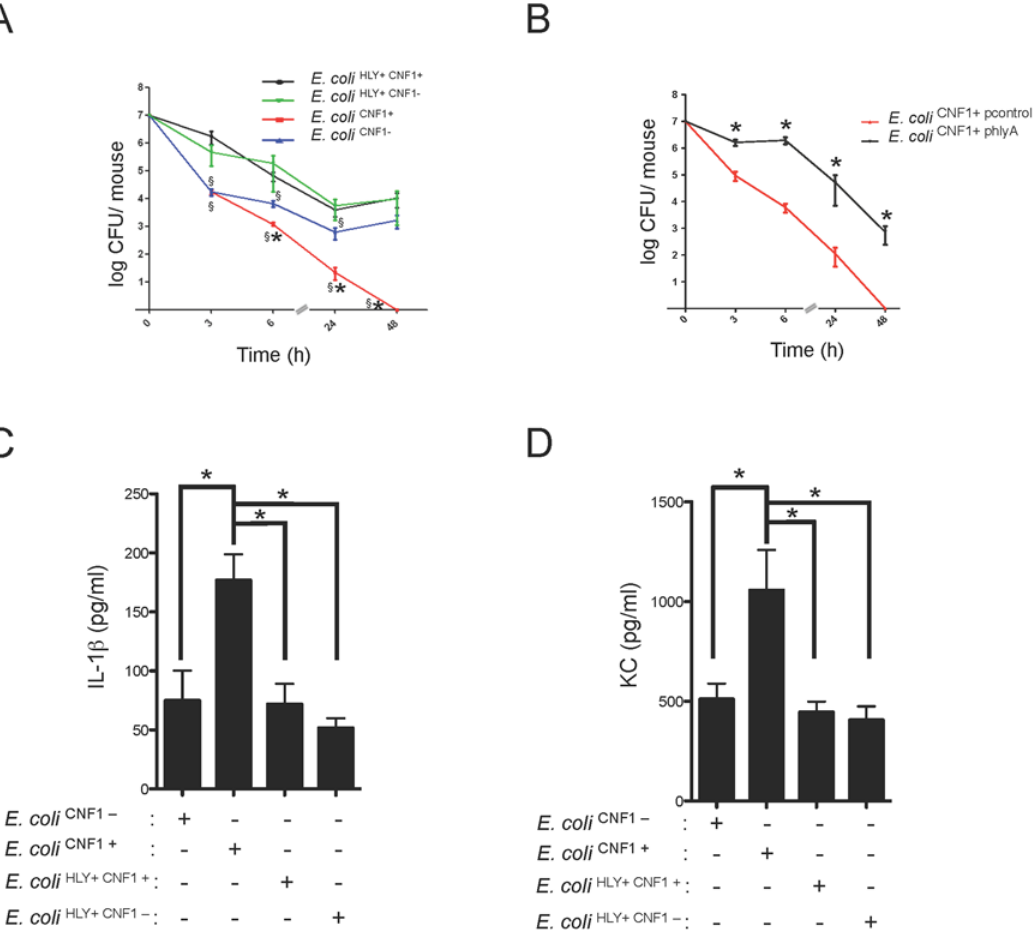
Fig 5. HlyA counteracts the CNF1-induced host response. (A) Female BALB/c mice were intravenously infected with 10 7 CFUs of E . coli expressing CNF1 ( E . coli CNF1+ ) or with 10 7 CFUs of one of the isogenic mutants, E . coli CNF1- , E . coli HLY+ CNF1+ or E . coli HLY+CNF1- , prior to the collection of peripheral blood at 3, 6, 24 and 48 h for bacteremia measurements. The data are presented as a line graph (n = 20 – 30; mean ± SEM). P-values < 0.05 compared to E . coli CNF1- are indicated by ( * ); and P-values < 0.05 compared to E . coli HLY+ CNF1+ are indicated by (§). (B) Female BALB/c mice were intravenously infected with 10 7 CFUs of the UTI89 Δ hlyA strain transformed with a control empty plasmid ( E . coli CNF1+ pcontrol ) or with a plasmid encoding HlyA ( E . coli CNF1+ phlyA ) prior to the collection of peripheral blood at 3, 6, 24 and 48 h for bacteremia measurements (n = 6 – 12). (C and D) Analysis of the circulating levels of IL-1 β and KC in the sera of C57BL/6 mice were measured by ELISA. Serum samples from mice infected with 10 7 CFUs of E . coli HLY+CNF1+ or with 10 7 CFUs of one of the isogenic mutants, E . coli CNF1+ , E . coli HLY+CNF1- , or E . coli CNF1- , were collected at 3 h after intravenous infection and analyzed by ELISA (n = 6). P-values < 0.05 ( * ); and P-values < 0.01 ( ** ) were considered statistically